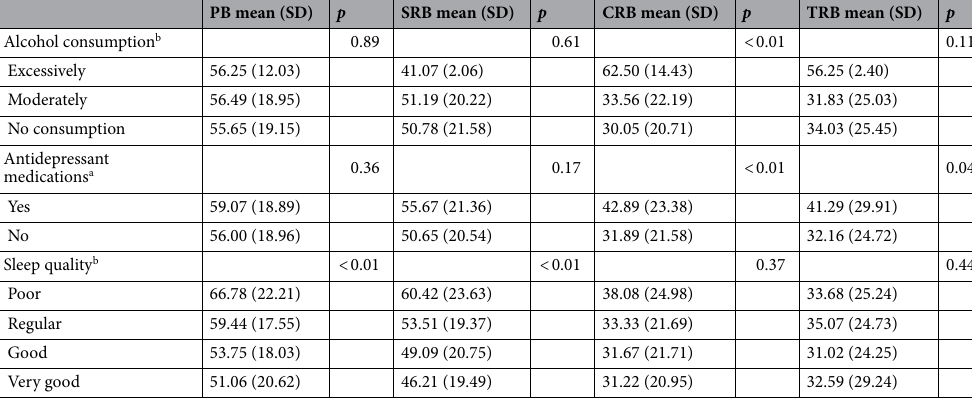
Table 4. Comparison of the mean of the CBI dimensions according to health and life habits